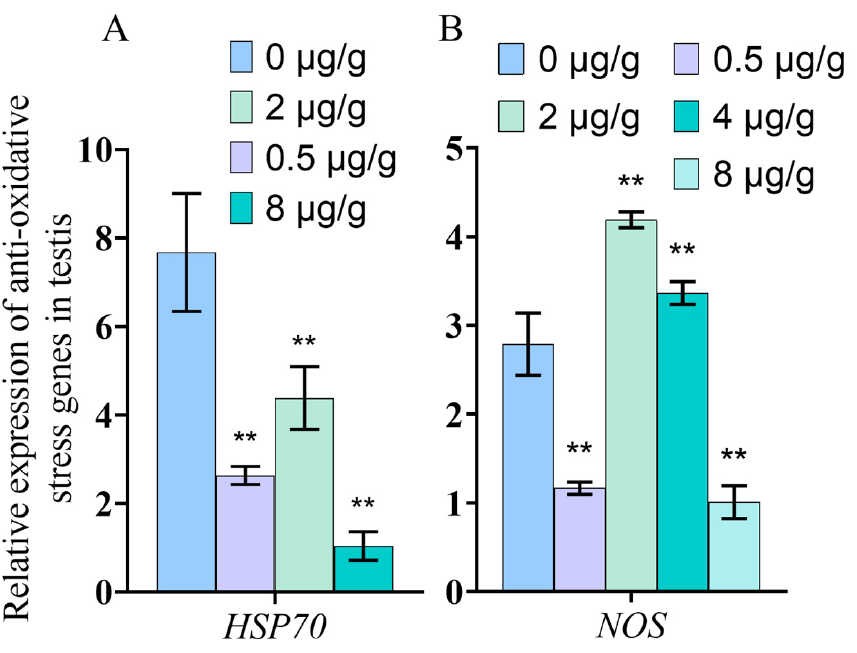
Figure 7. Anti-oxidative stress gene expression. ( A ) The expression of the HSP70 gene in the testis decreased significantly. ( B ) The expression of the NOS gene in the testis decreased significantly in the 0.5 μ g/g and 8 μ g/g SOV groups, but increased significantly in the 2 μ g/g and 4 μ g/g groups. (** indicates significant compared with control group; **: p < 0.01).